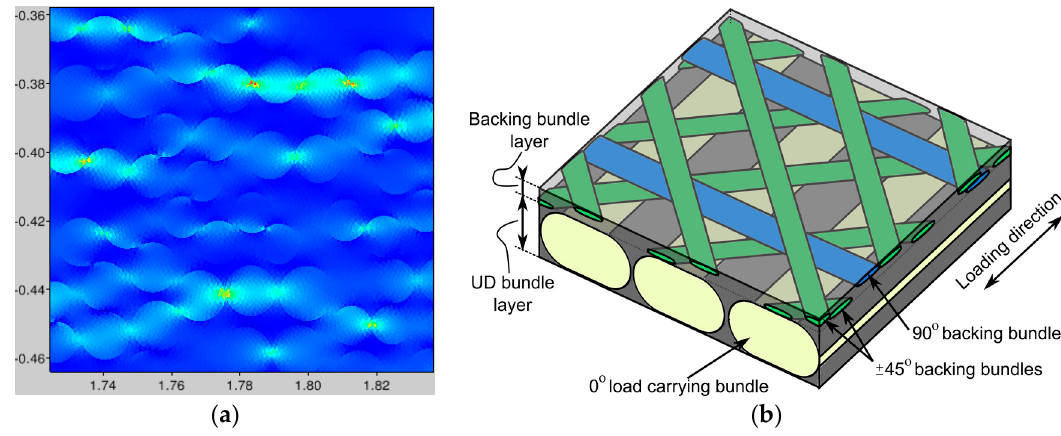
Figure 5 ( a ) The normal horizontal stress contour plot of a transverse-loaded 45° backing bundle and ( b ) the 3D structure where the resulting constitutive law will be implemented.